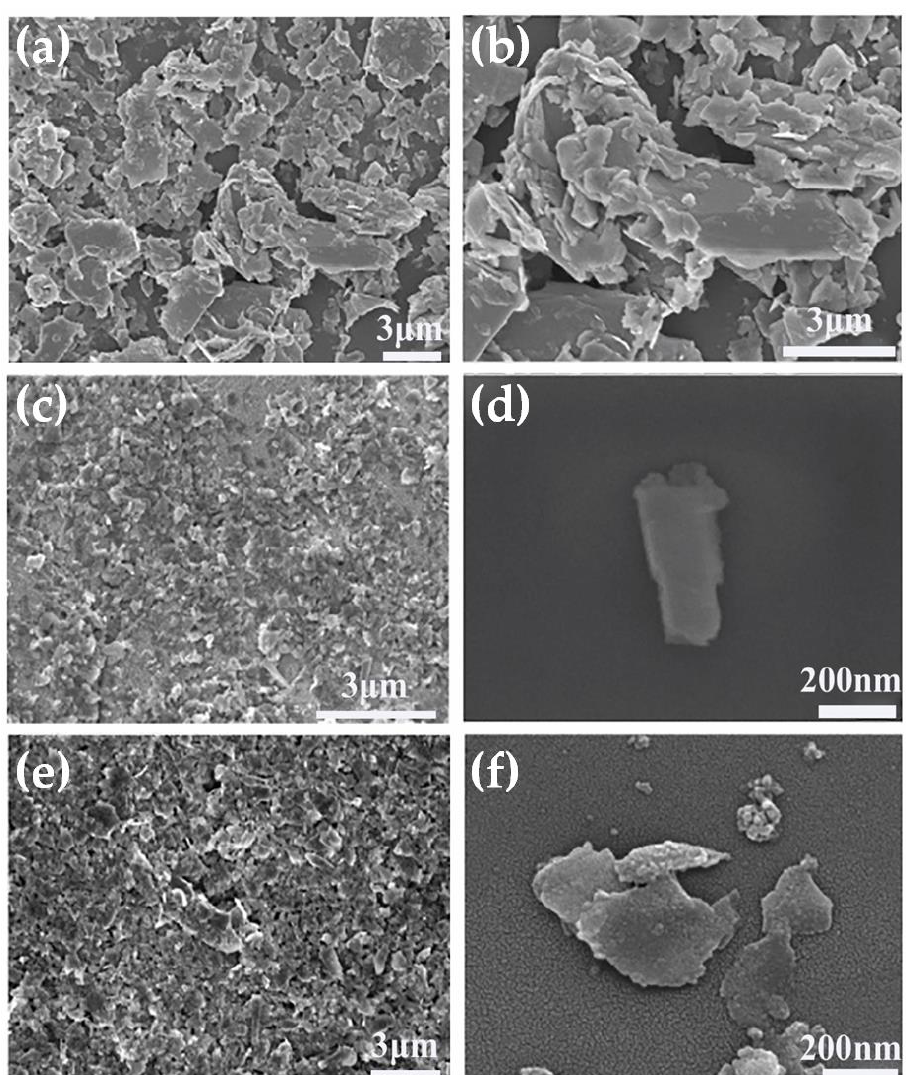
Figure 3. ( a , b ) SEM images of bulk MoS 2 . ( c , d ) MoS 2 nanosheets obtained by grinding with ACN (S1). ( e , f ) MoS 2 nanosheets obtained by grinding with NMP (S2).